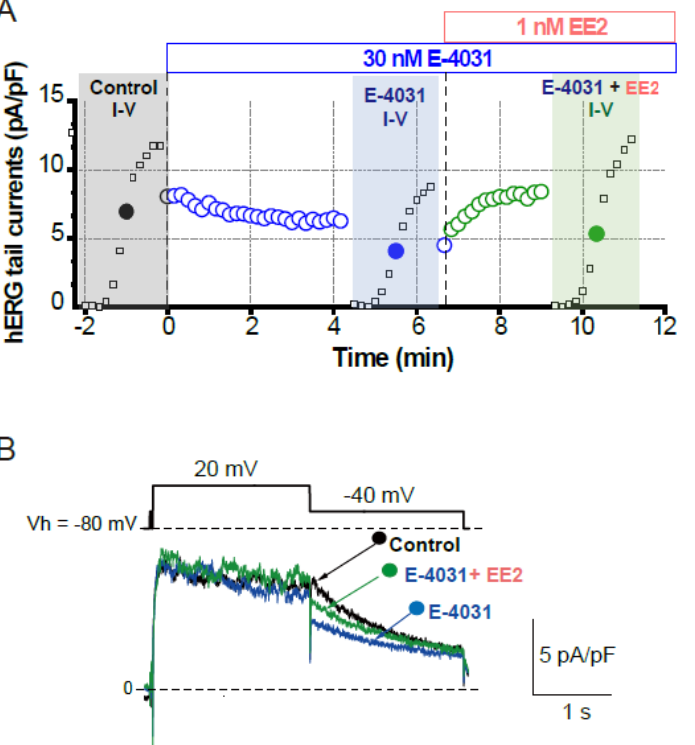
Figure 3. Effects of EE2 on blockade of hERG currents by E-4031. HERG currents were recorded from HEK293 cells stably expressing hERG as described in Figure 1. ( A ). Time course of hERG tail current blockade by E-4031 at 30 nM and the following recovery by the addition of EE2 at 1 nM. Plots from a representative experiment are normalized by the tail amplitude before E-4031 application (time 0). The current-voltage (I – V) relationships were tested before drug application (control, black), after E-4031 block (blue) and after the addition of EE2 (E-4031 + EE2, green). ( B ). Representative traces elicited by 20-mV test pulse (closed circles in I – V relationships) are shown by superimposing the traces before (control, black) and after the application of E-4031 only (blue) and E-4031 plus EE2 (green). Scale, 5 pA/pF, 1 s.